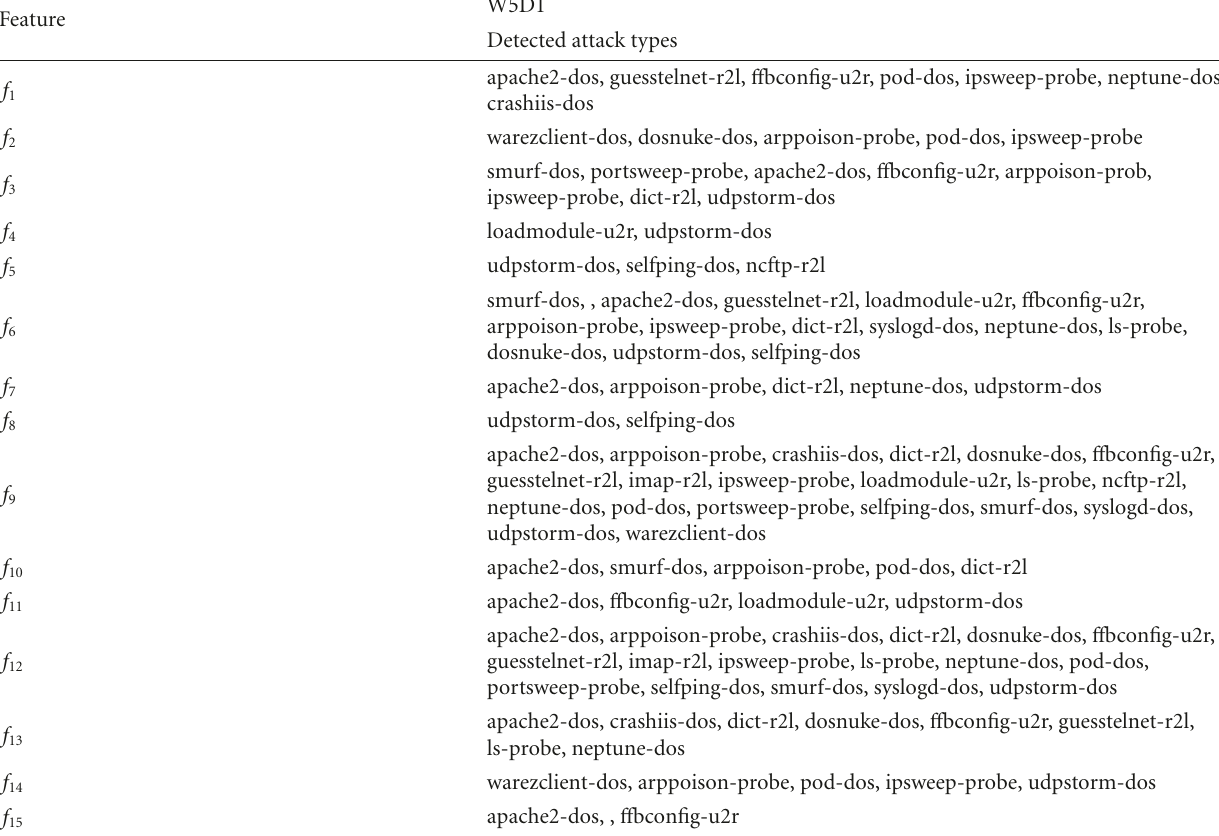
Table 5: Number of attack types detected for each feature for W5D1.